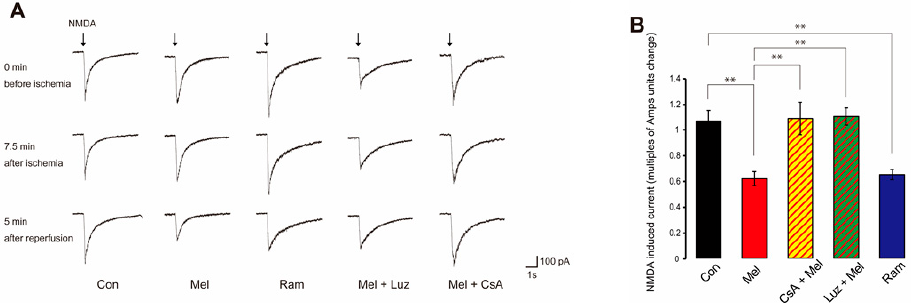
Figure 4. Effect of post-ischemic treatment and post-anoxic melatonin administration on N-methyl- D-aspartate (NMDA)-induced currents recorded from voltage-clamped hippocampal pyramidal neurons. ( A ) Typical traces of NMDA-induced currents prior to anoxia, at the end of anoxia, and after 5 min of anoxia in the Control, Mel, Ram, Mel + Luz, and Mel + CsA groups. Inward currents are represented by downward deflection. In the Mel group, NMDA-induced currents decreased and no change in waveform was seen after 5 min of anoxia. The control group showed no obvious change in NMDA-induced current. ( B ) Bar graph showing the change in mean peak amplitude of NMDA-induced current from 10 min to 20 min after anoxia in the control group, Mel group, Ram group, Mel + Luz group, and Mel + CsA group. Values are shown as currents in multiples of Amps units change relative to mean peak amplitude during the 5 min prior to anoxia. Asterisks indicate significant differences in Tukey–Kramer multiple comparisons test (** p < 0.01). NMDA—N-methyl-D- aspartate; Con—control; Mel—melatonin; Ram—ramelteon; Luz—luzindole; CsA—cyclosporine